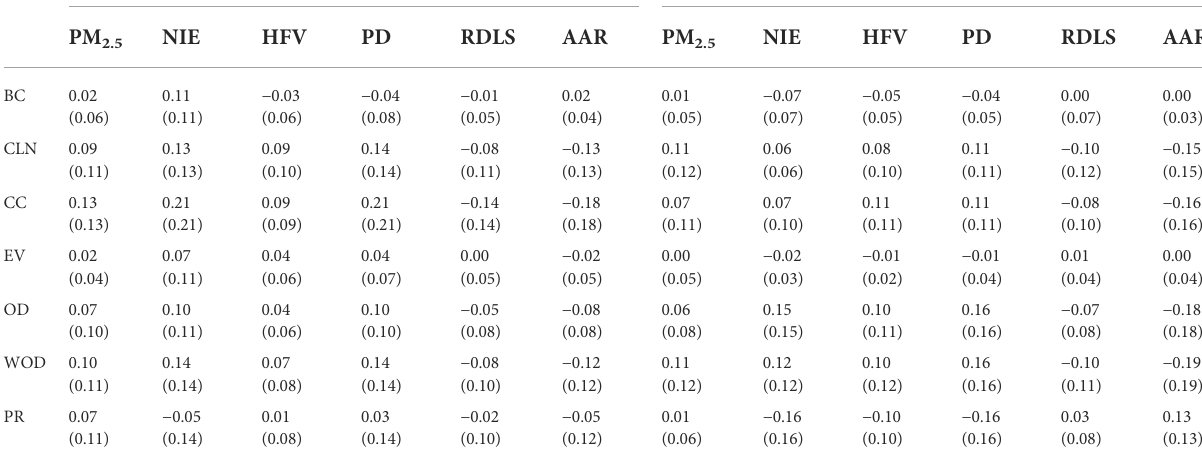
TABLE 1 Correlation coef fi cient matrix of network indicators and determinants on multiple timescales. Panel A: Undecomposed data Panel B: Short timescale